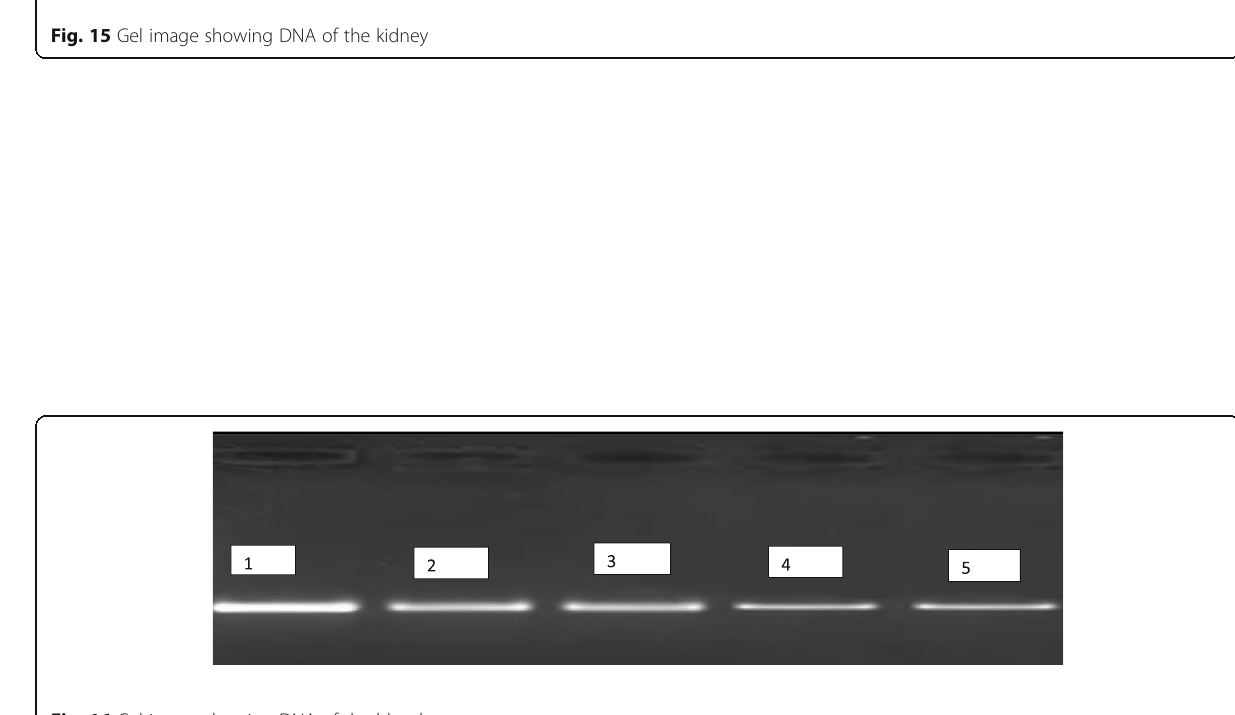
Fig. 16 Gel image showing DNA of the blood